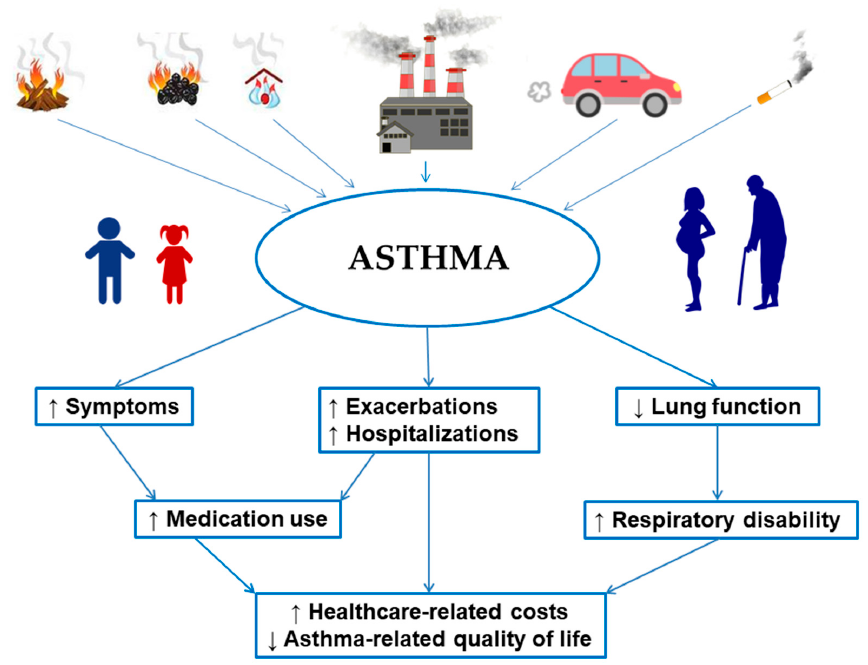
Figure 1. Burden of air pollutants on asthma outcomes and socio-economic impact.